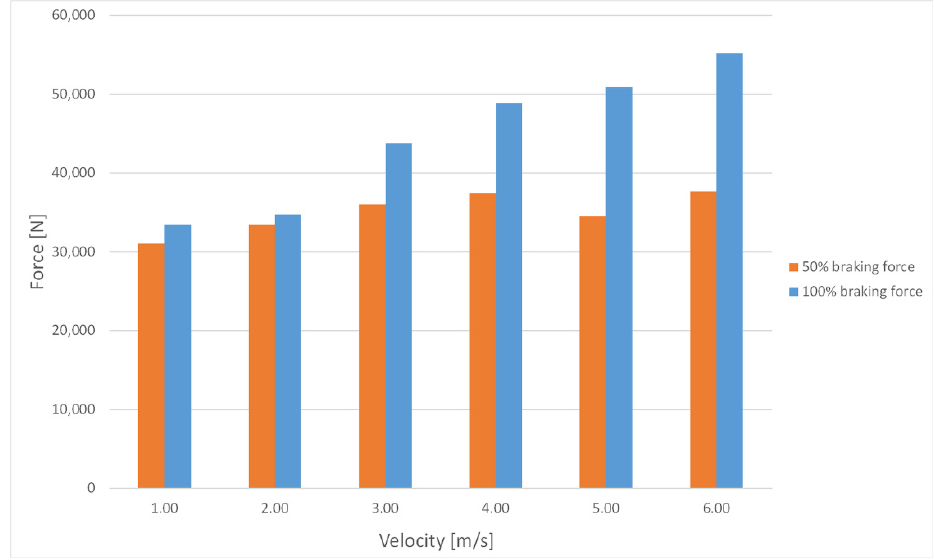
Figure 12. Maximum forces in the suspensions, in relation to maximum speeds, when braking with full and reduced braking force.